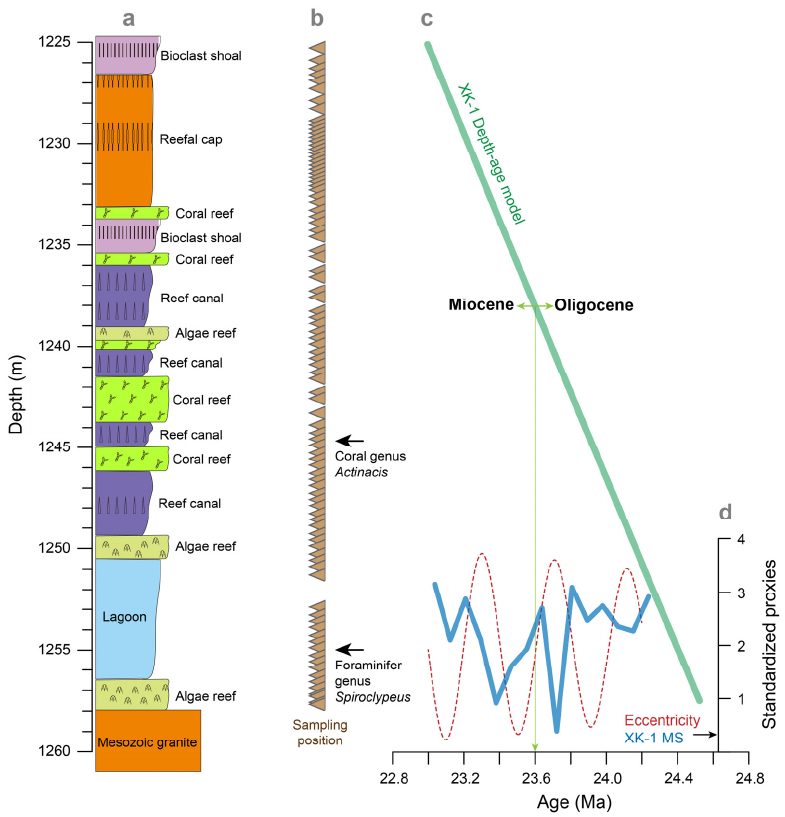
Figure 2. Profile of the studied section of core XK-1. ( a ) Lithological changes. ( b ) Sampling position. ( c ) The preliminary age-depth model of core XK-1. ( d ) Comparison between orbital eccentricity on 405 kyr band and magnetic susceptibility (MS) of core XK-1 on the preliminary timescale. The data presented in ( c , d ) were from Reference [18] .